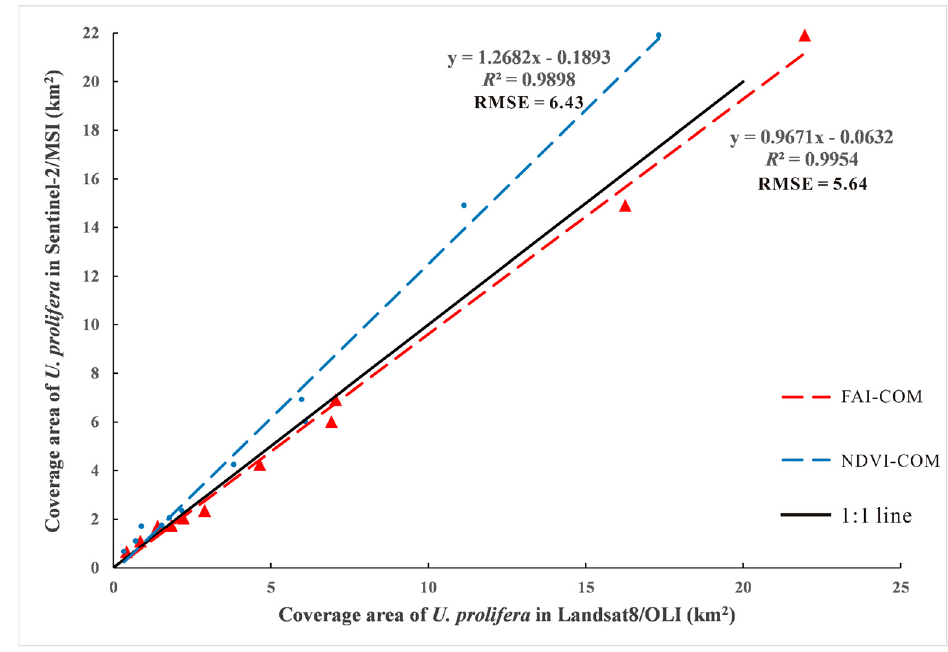
Figure 9. Accuracy comparison of two models for extracting U. prolifera in Landsat8/OLI images. The coverage area of U. prolifera in Sentinel-2/MSI is taken as the true value. Table 3. Statistical table of cloud cover information in the date when FAI-COM was not able to extract U. prolifera